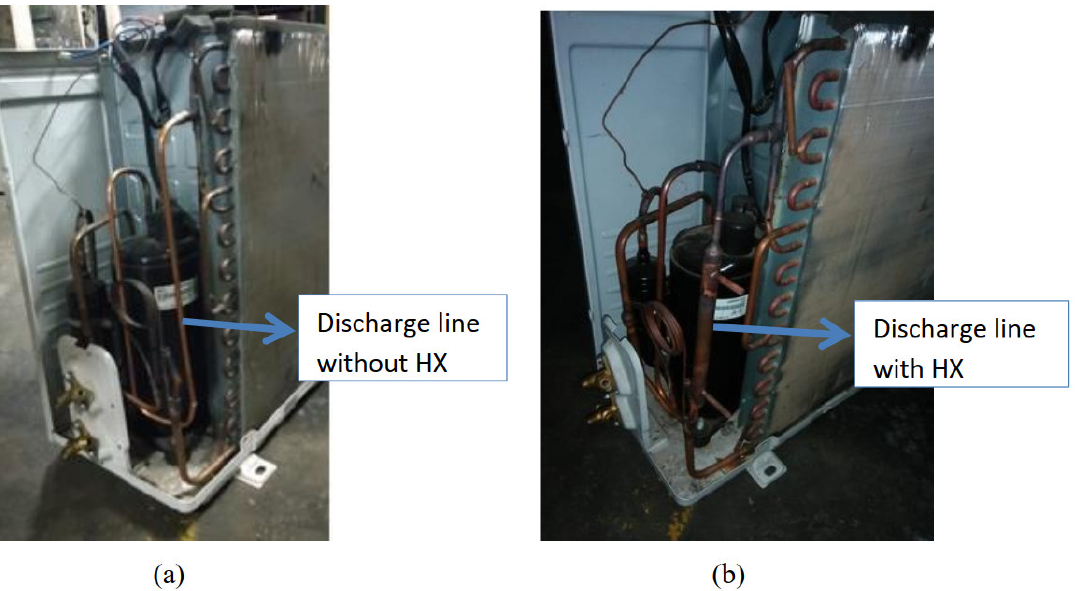
Figure 3. The discharge line of the outdoor unit ( a ) without heat exchanger as subcooler and ( b ) with a heat exchanger as a subcooler (length, L = 22 cm).